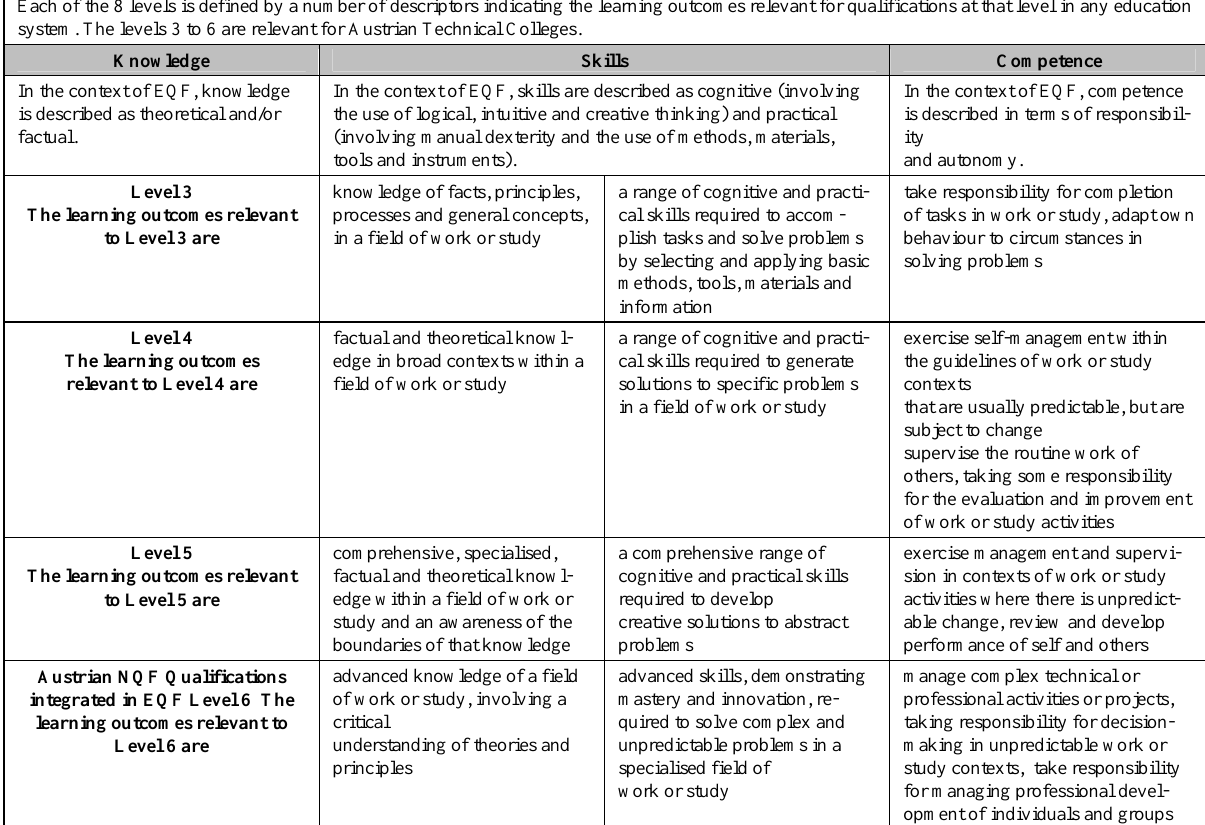
TABLE II. DESCRIPTORS DEFINING LEVELS IN THE EUROPEAN QUALIFICATIONS FRAMEWORK (EQF), EXCERPT [9]